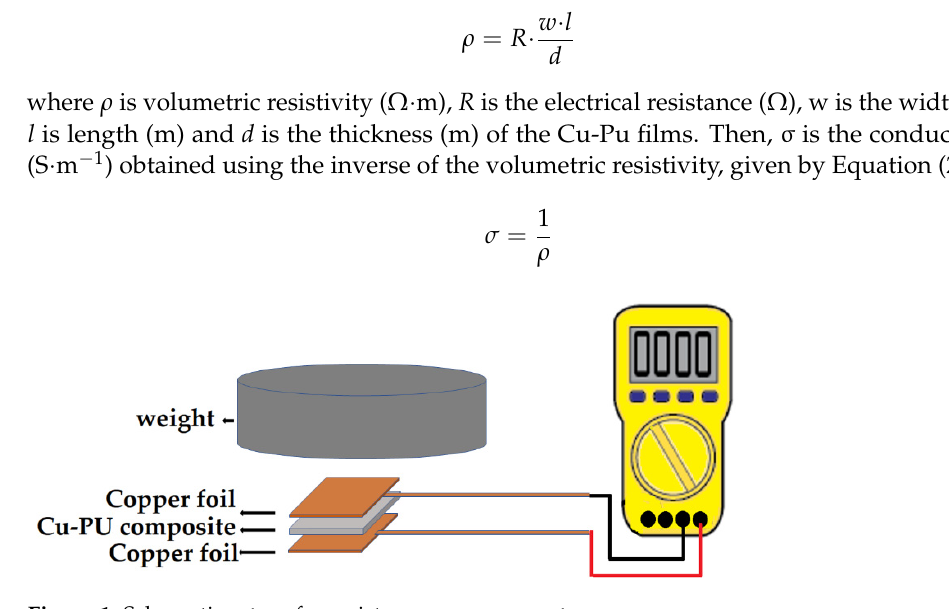
Figure 1. Schematic set up for resistance